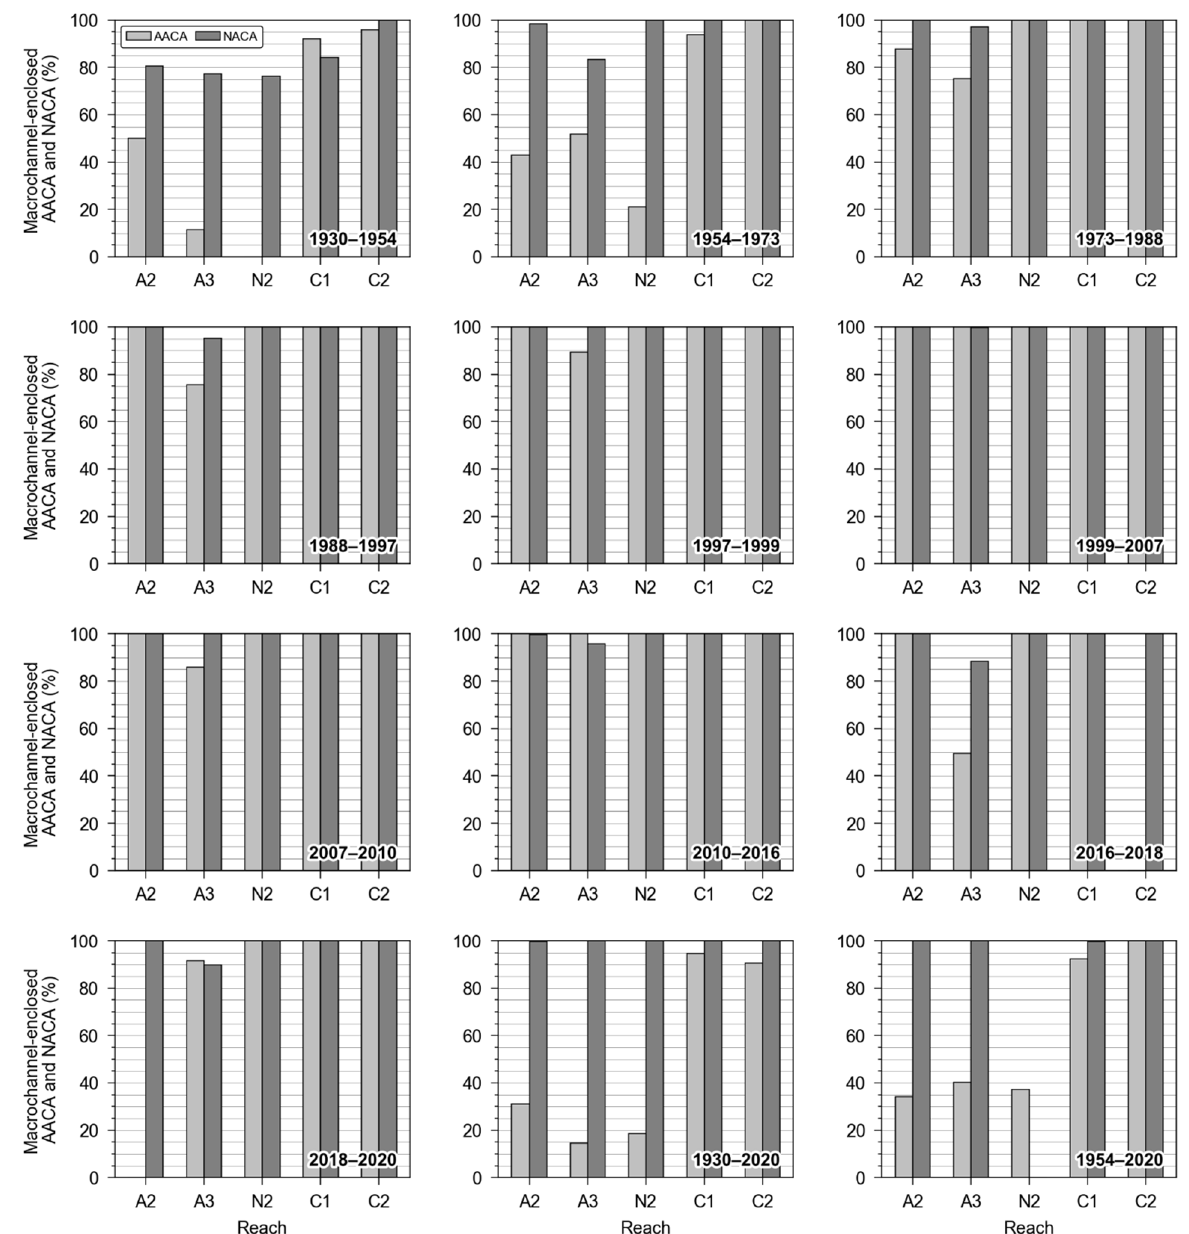
Figure 8. Abandoned (AACA) and newly formed (NACA) active channel areas included within the macrochannel referred to each period investigated and to the periods 1930–2020 and 1954–2020. The macrochannel was mapped in reaches A2, A3, N2, C1, and C2. A1 and N1 were excluded due to the lack of continuous or almost continuous longitudinal bank protections or numerous groynes that allow the macrochannel to be mapped.